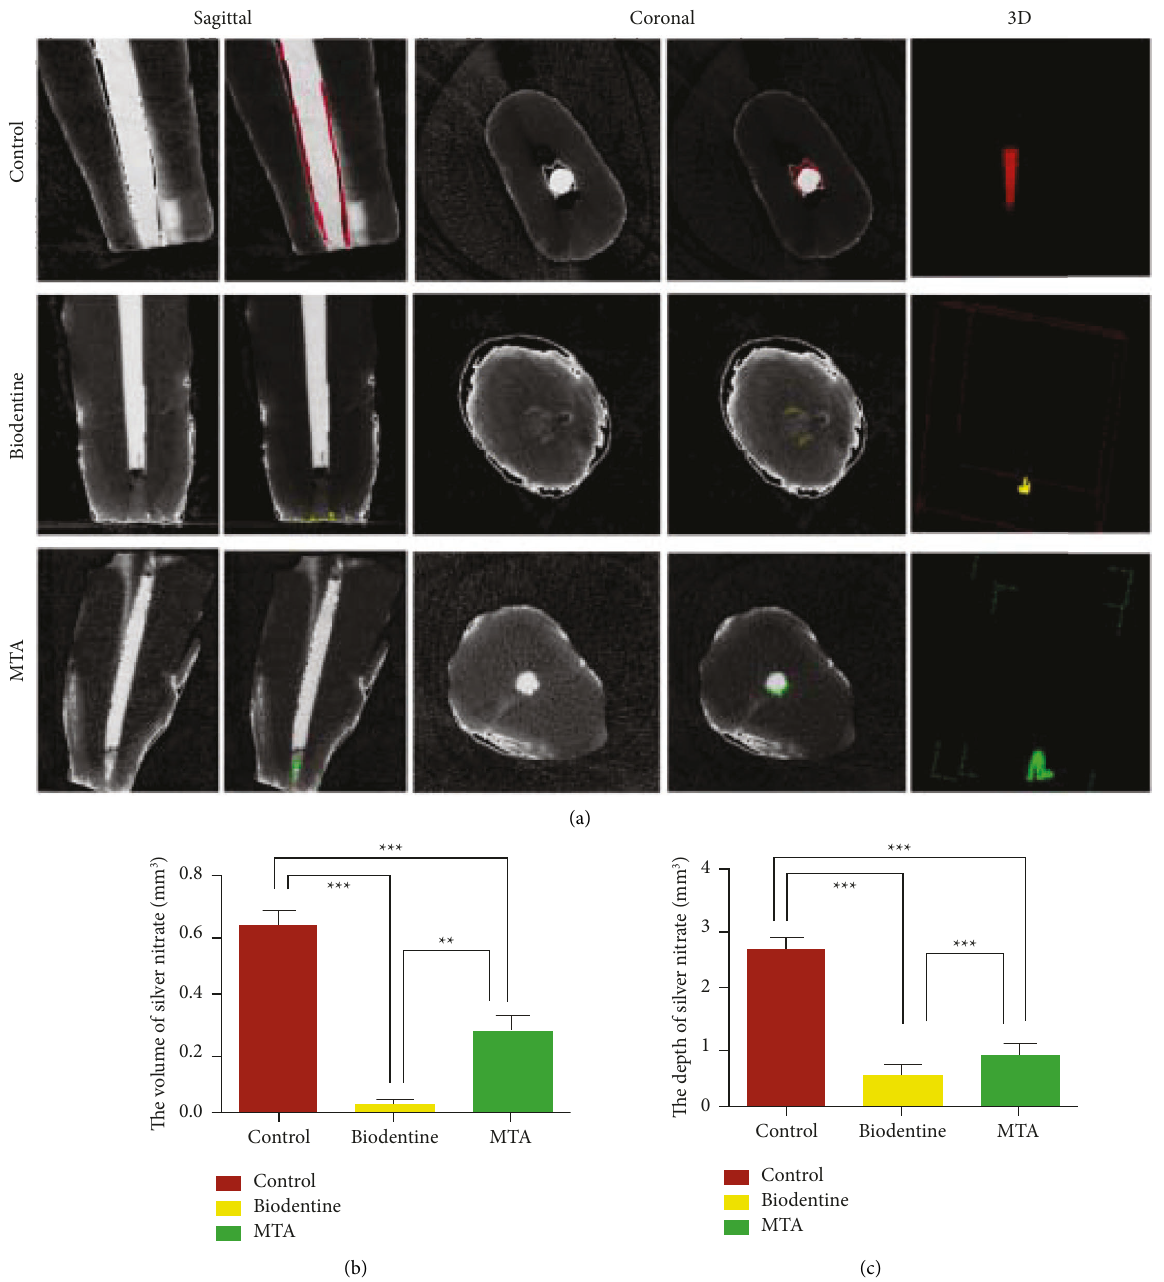
Figure 2: Microleakage evaluation by a micro-CT analysis. (a) Micro-CT images representing the silver nitrate solution volume which infiltrated root canals in each of the studied groups. (b) Quantitative assessment of nitrate solution volume which infiltrated root canals. (c) Quantitative assessment of nitrate solution depth which infiltrated root canals. ∗∗ P < 0 . 01 and ∗∗∗ P < 0 . 001